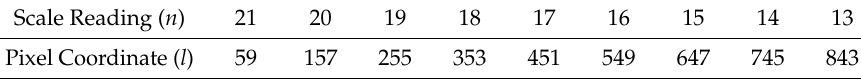
Figure 12. Recognition results for digital and scale line. Table 2. A relationship table between the scale indicator and pixel values.